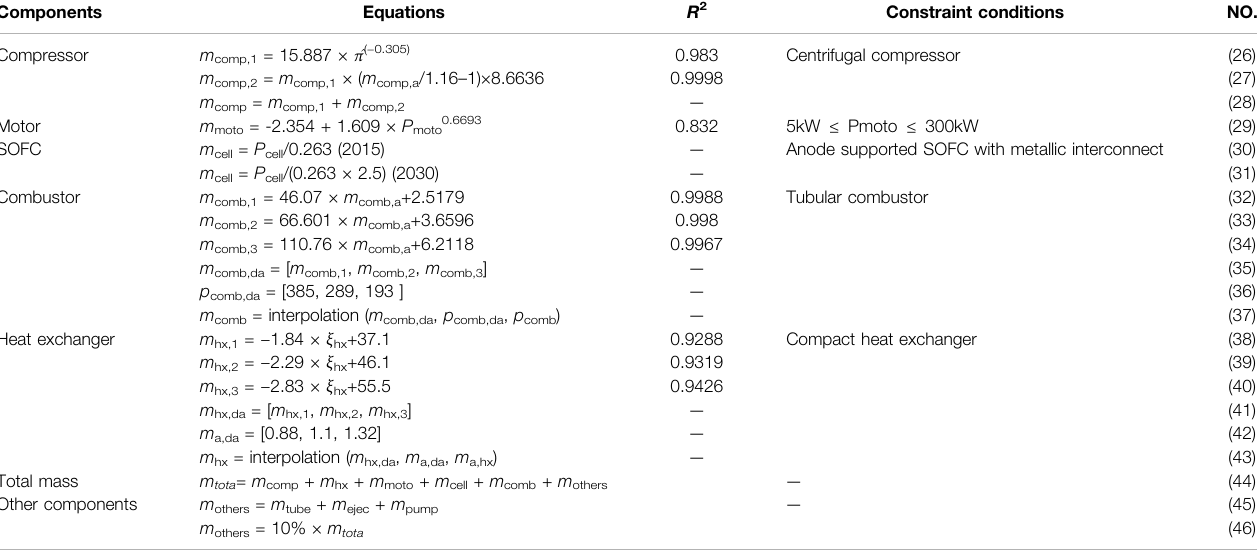
TABLE 1 | Mass models of sub-components of the HEFC engines (Tornabene et al., 2005; Valencia et al., 2015; Cirigliano et al., 2017). Components Equations R